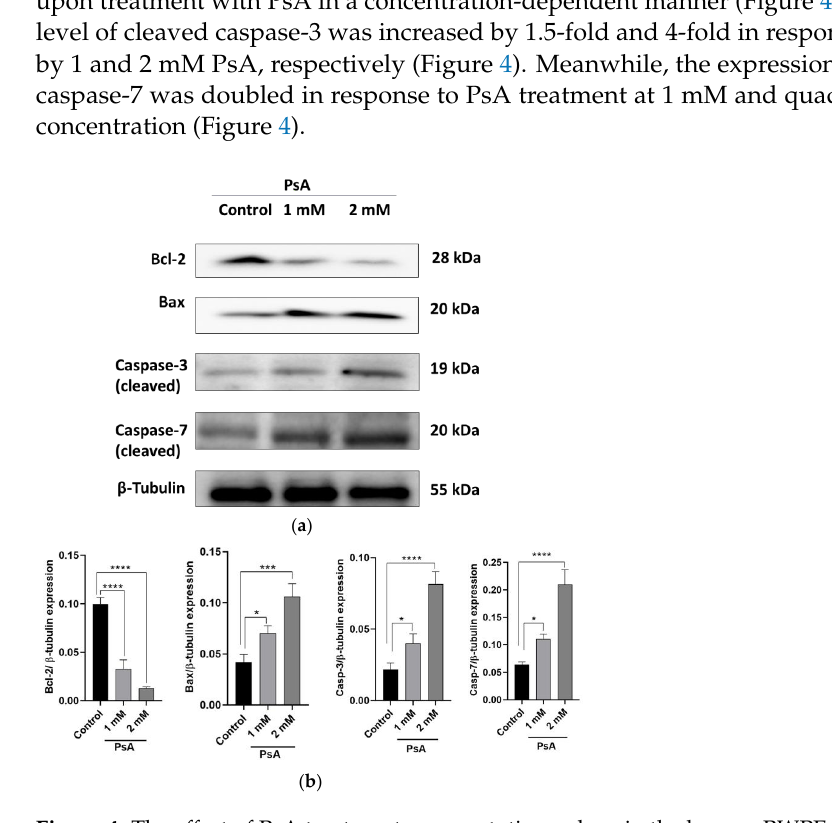
The LD 50 of PsA orally administered was determined to be > 550 mg/kg. A total of four Swiss albino mice (two male and two female) were utilized in this experiment. The first mouse was administered an oral dose of PsA at 175 mg/kg in accordance with the Organization of Economic Co-operation and Development (OECD) guideline 425 [27] suggestion for the starting dose. No behavior, neuromuscular, nor autonomic changes observed at any time points. No animal morbidity was observed over 48 h. Each of the other three mice administered PsA 550 mg/kg oral dose. No morbidity over 48 h nor any changes in behavior, neuromuscular, autonomic responses observed at any time point. Limits of PsA solubility prevented increasing the dose to 2000 mg/kg, which is the upper limit of the Up-and-Down procedure [27]. 2.3. 14-Day Acute Toxicity Assay of Pseurotin A 2.3.1. PsA Effects on Mouse Body Weight Following a single oral administration of PsA, the bodyweight of the treatment groups for the male mice did not show any significant changes over the five time points measured. The 10 mg/kg and 250 mg/kg PsA treatment groups lost weight over 11 days but a reversal of that trend was observed and the mice gained weight from day 11 to 14. The 500 mg/kg group was the only group that lost notable weight over the entire 14 days (Figure 5). The 500 mg/kg treatment group for the female mice showed a drastic decrease in body weight in the first four days, which continued to decline at each time point measured until the day of sacrifice (Figure 5). The female mice body weight of the 10 mg/kg and 250 mg/kg treatment groups remained constant and did not differ from the control group. This extreme loss in body weight from the female group could be attributed to the PsA’s PCSK9 inhibitory effect that has been shown to lower the amount of LDL cholesterol by a significant margin [11,23].